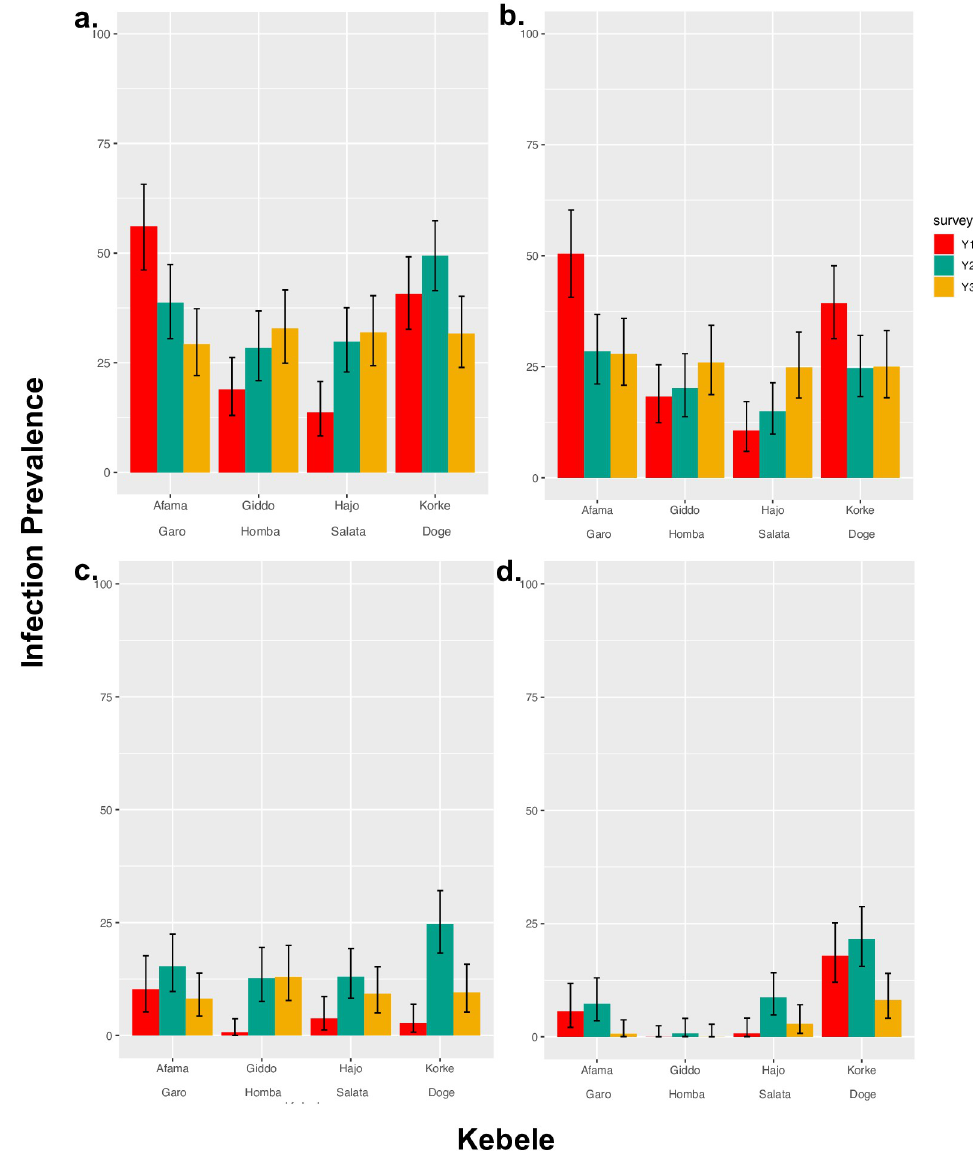
Fig 2. Infection prevalence across cohort populations within kebeles stratified by yearly surveys. Each plot represents species-specific prevalence of a . Any STH, b . A . lumbricoides , c . Hookworm, d . T . trichiura . Vertical Error bars represent 95% confidence